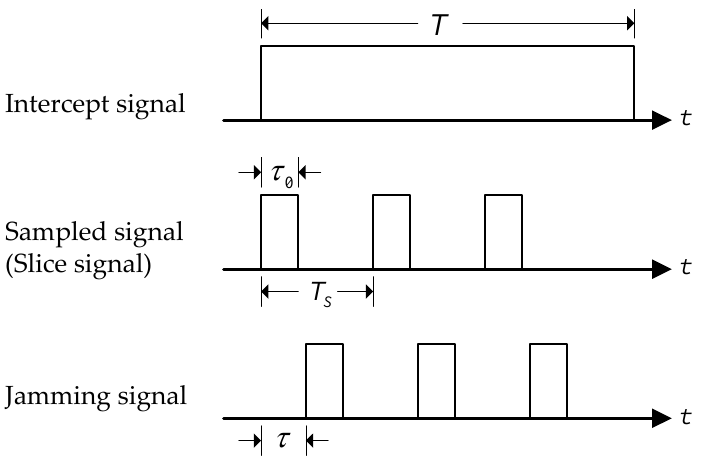
Figure 2. Schematic diagram of slice repeater jamming model. For the specific slice repeater jamming whose slice signal width is equal to the width of the FSK-PSK intra-sub-pulse signal, the intra-sub-pulse orthogonal waveform can be used to suppress the repeater jamming